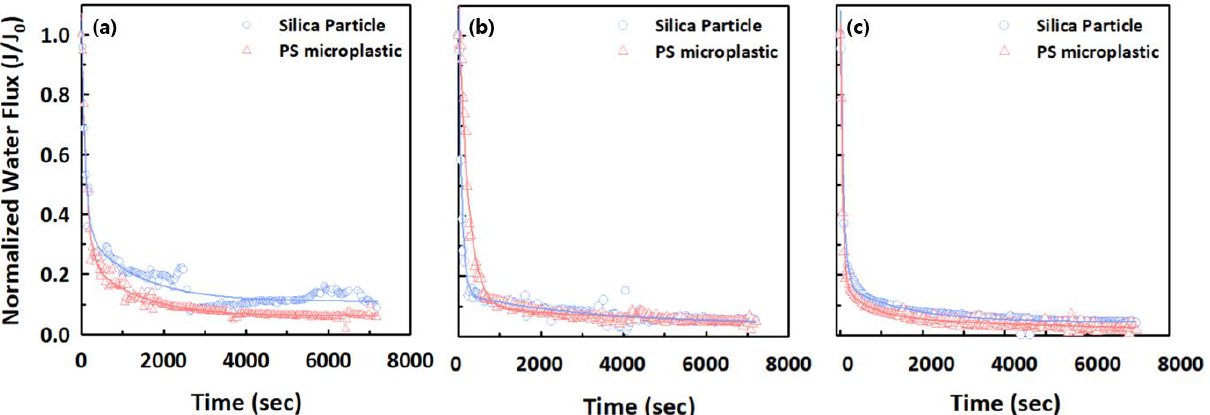
Figure 1. Normalized water flux decline of silica and PS microplastic particles with an average size of 0.1 μm for ( a ) Synder, ( b ) SteriLUX ® , and ( c ) Anodisc membranes.